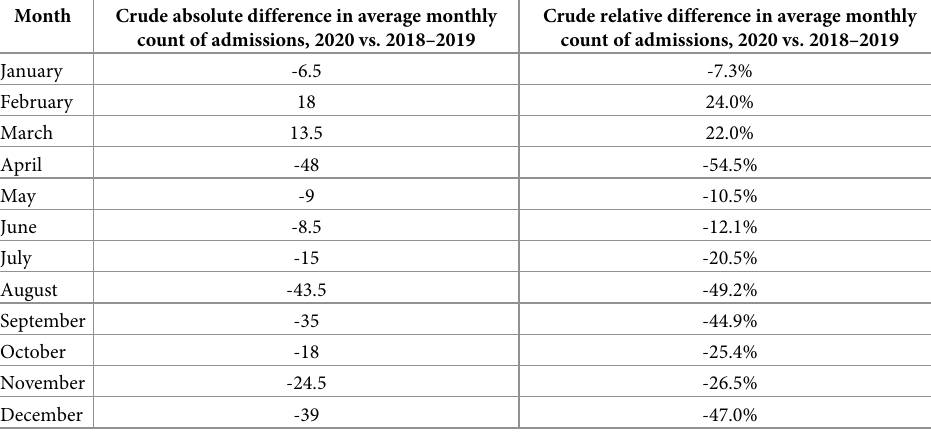
Table 1. Crude absolute and relative differences in average monthly count of hospital admissions, 2020 vs. 2018– 2019. Month Crude absolute difference in average monthly count of admissions, 2020 vs.